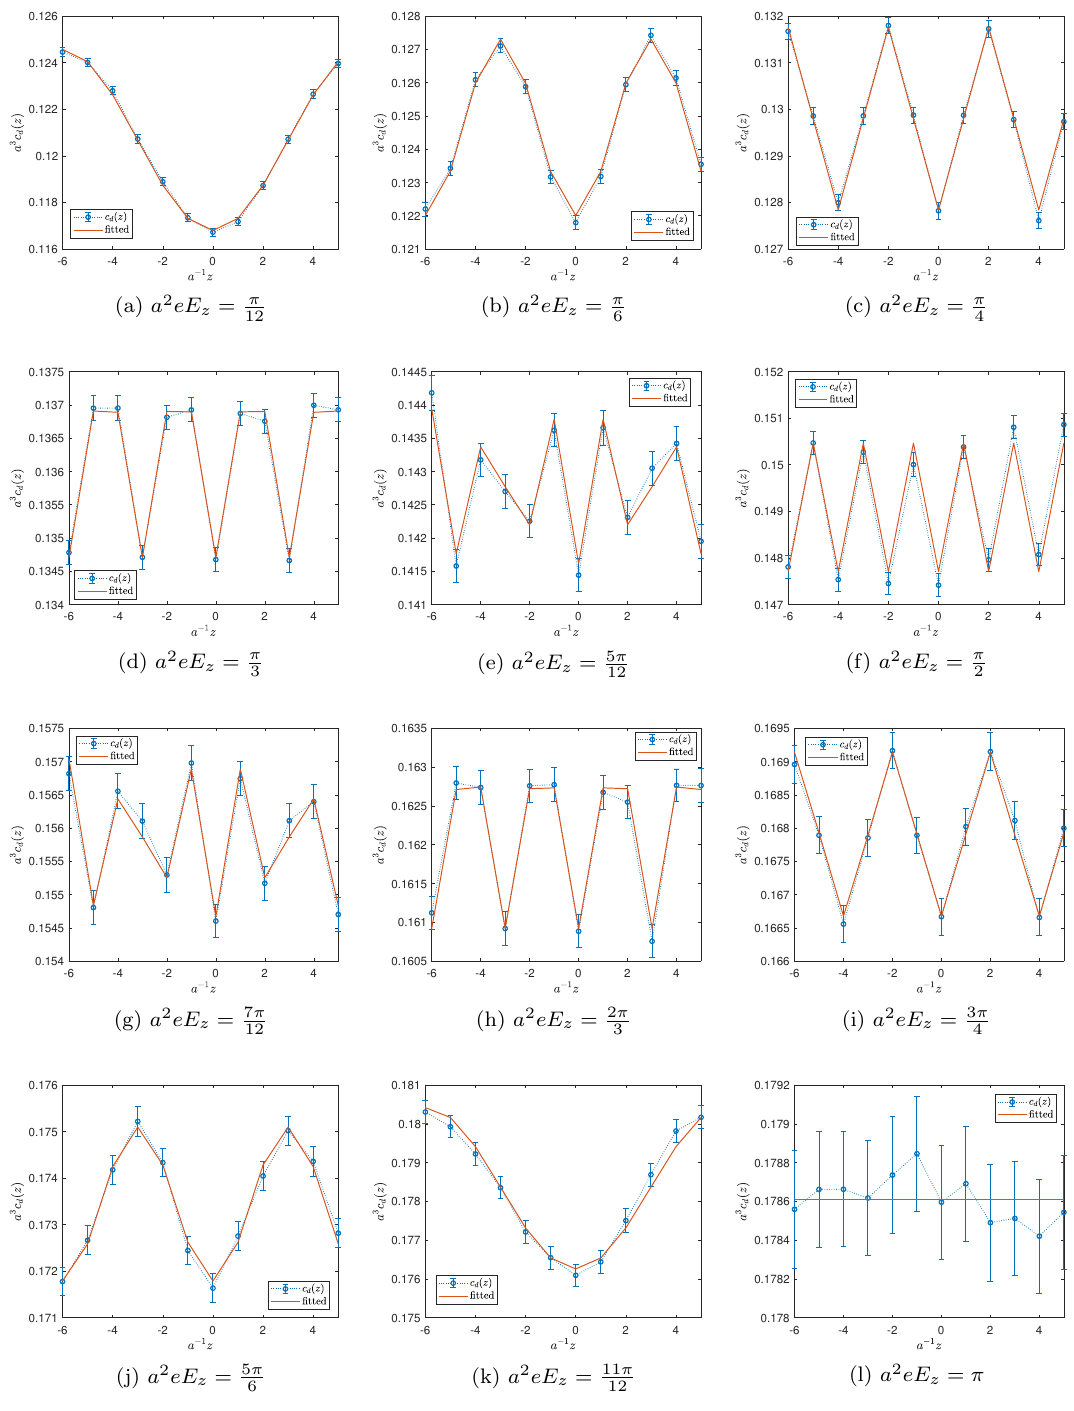
Figure 7 . Same as figure 6 but for c d ( z ) at β = 5 . 64